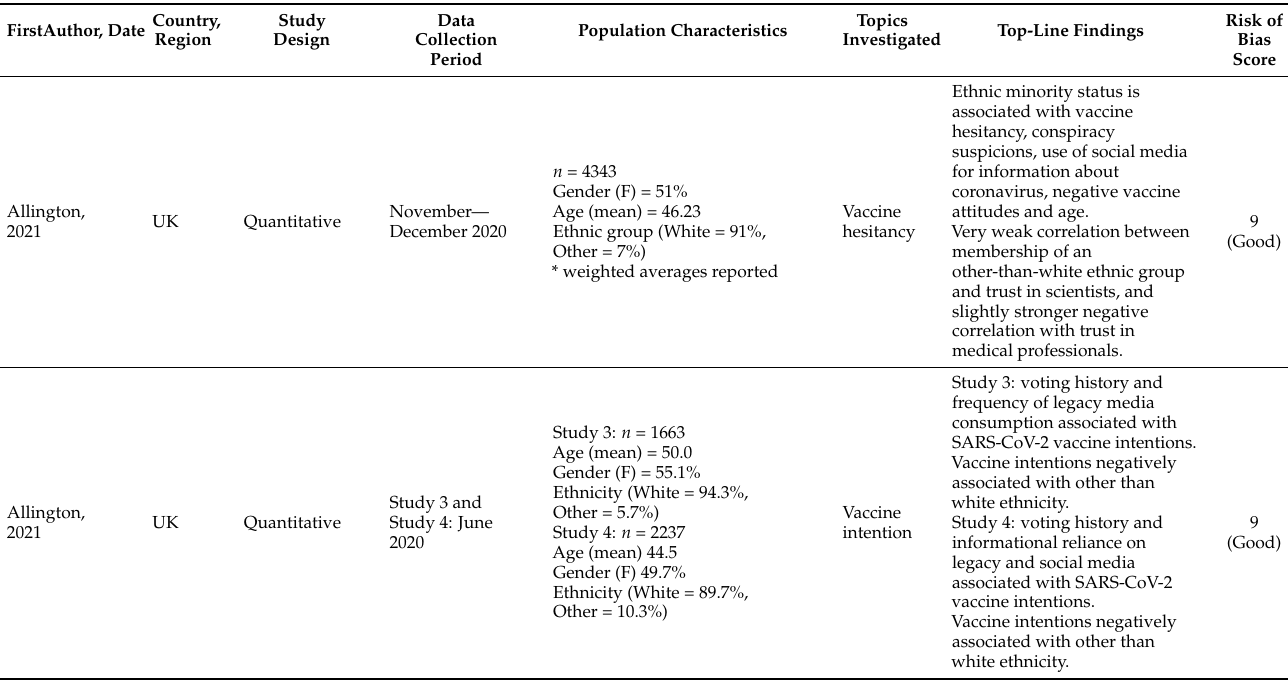
Figure 1. PRISMA Flowchart depicting the selection of studies for the rapid systematic review. Table 1. Study